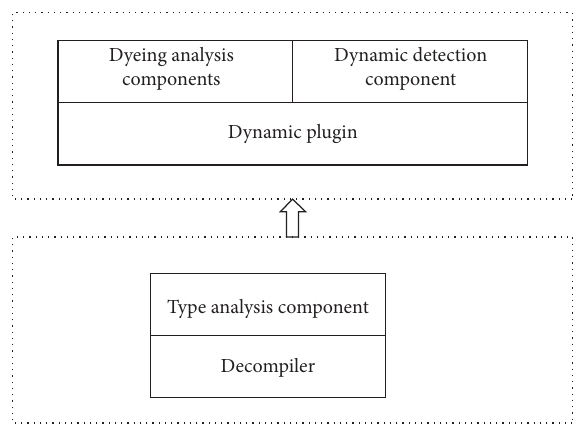
Figure 3: Structural diagram of the detection tool.